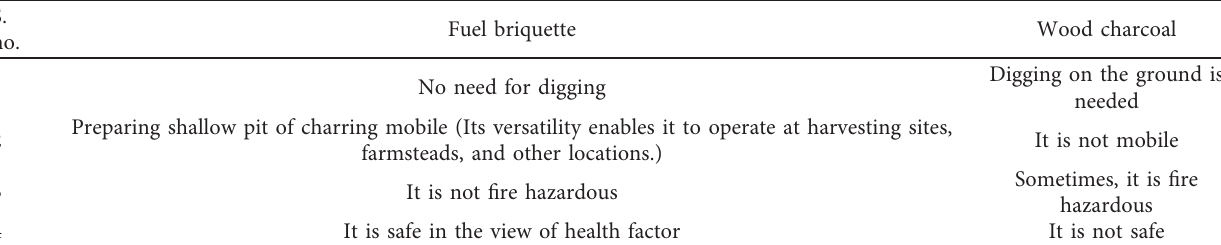
Table 6: Comparison of the processes of producing wood charcoal and fuel briquette